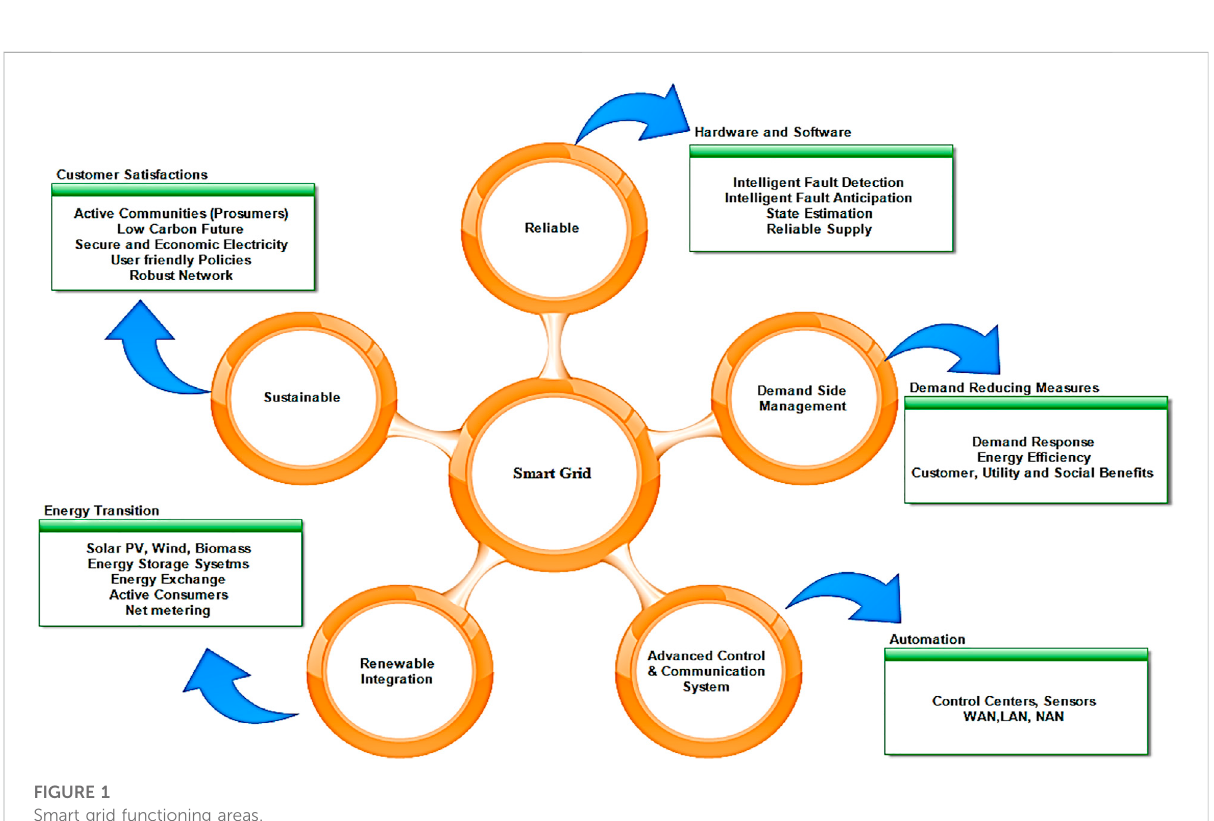
FIGURE 1 Smart grid functioning